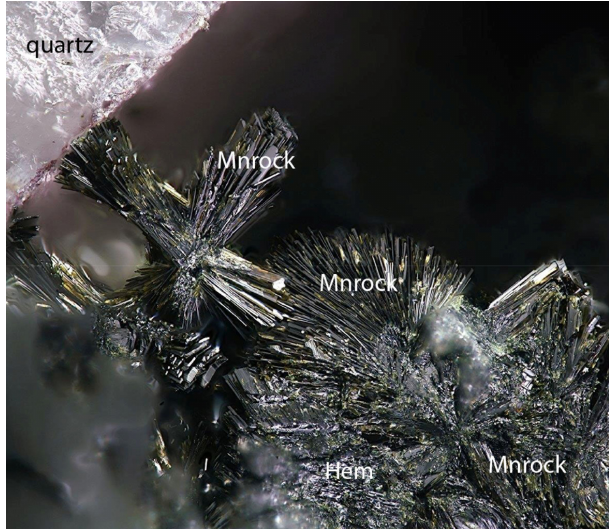
Figure 1. Manganrockbridgeite laths. Field of view: 0.7mm. Photo by Christian Rewitzer.